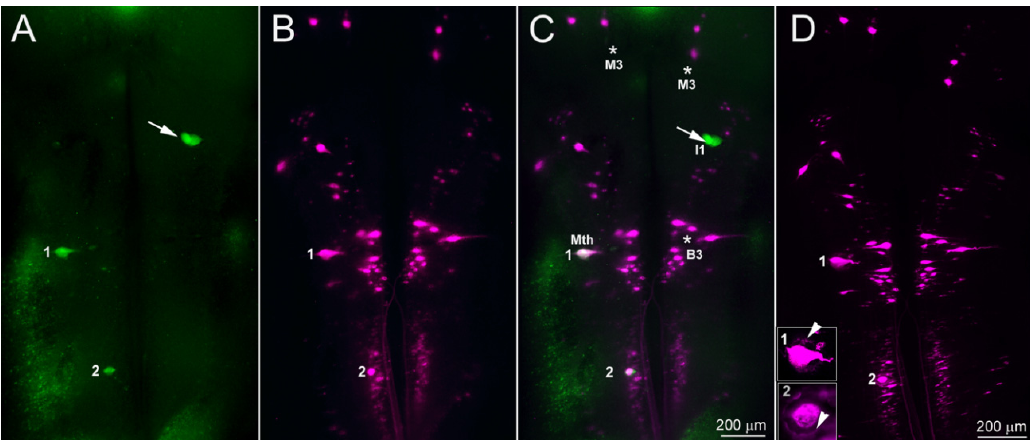
Figure 5. BABB clearing can be applied after FLICA to image regeneration and apoptotic signaling in the same preparation. Thirteen weeks after a TX at the level of the 5th gill, DTMR was applied to a 2nd TX 5 mm caudally. ( A ) after another 8 weeks of recovery, the brain was processed by FLICA (green) to image activated caspases. ( B ) RS neurons whose axons had regenerated at least 5 mm beyond the original TX are labeled red. ( C ) merged ( A and B ). A neuron labeled only in green (white arrow in A and C ) is apoptotic due to the original TX. The locations of three identified bad regenerators (the right and left M 3 and the right B 3 ), which are not labeled by either DTMR or FLICA, are indicated by asterisks. These neurons probably are in a late stage of apoptosis or are already dead. Two neurons labeled by both DTMR and FLICA (marked 1 and 2) survived and regenerated their axons after the first TX, but are nevertheless undergoing delayed apoptosis due to the second TX. Number 1 is the left Mauthner neuron, ordinarily a bad regenerator and bad survivor. Number 2 belongs to the left PRRN, whose axons in agregate were reported to have a 31% probability of regenerating [2]. Images in ( A–C ) are captured by widefield fluorescence microscopy before BABB clearing. The calibration bar in ( C ) is for all three frames. ( D ) after BABB clearing, the same brainstem shows greatly improved resolution, with approximately 50% more DTMR-labeled neurons visible. The neurons marked 1 and 2 are enlarged in boxes and show pathological morphologies—swelling and impaired membrane integrity (arrowheads).